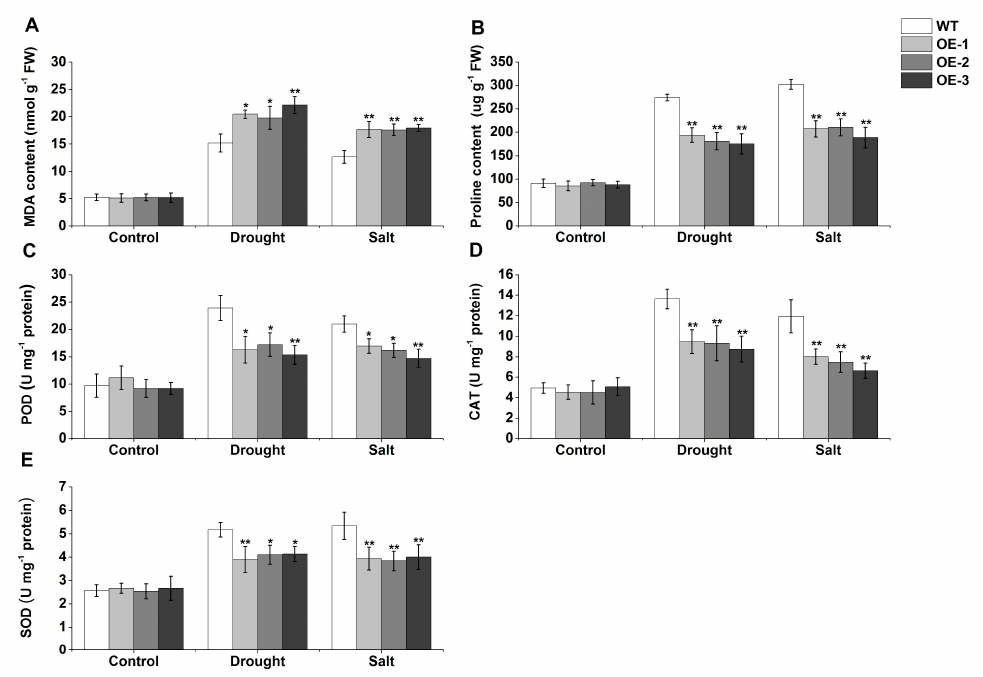
Figure 11. The effect of drought and salt stresses on MDA ( A ); proline ( B ); and the activities of POD ( C ); CAT ( D ); and SOD ( E ) in TaERF-6-3A transgenic Arabidopsis lines. Standard deviations are indicated by error bars (mean ± SD and n = 3) and significant differences are indicated using asterisks (ANOVA, * p < 0.05; ** p < 0.01).